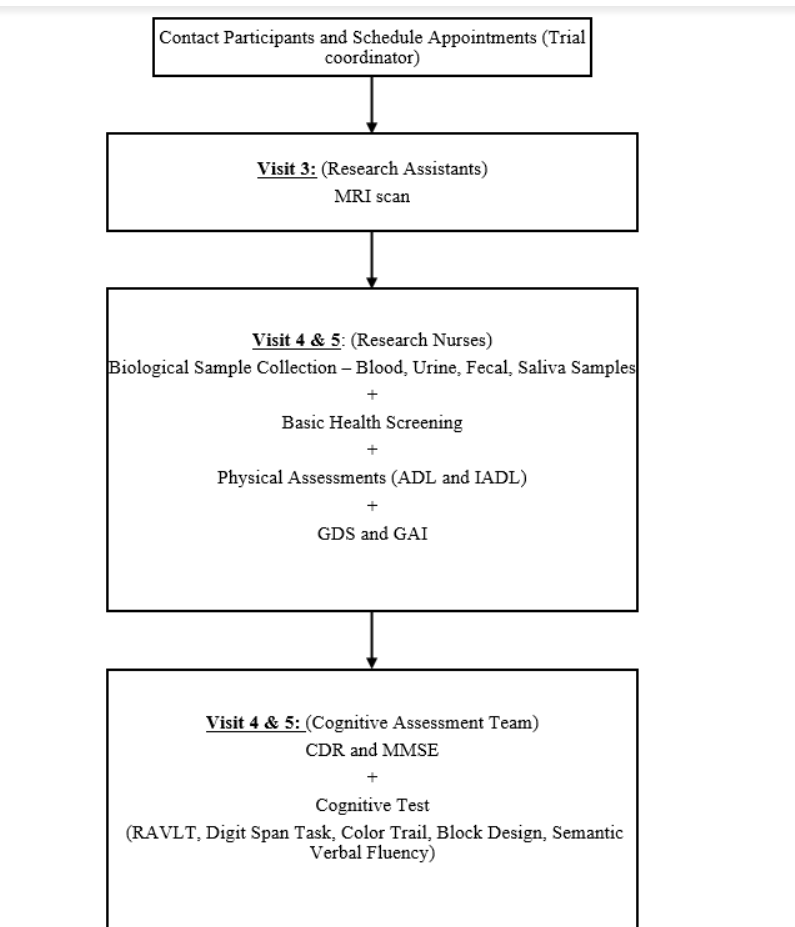
Figure 2. Flow Chart of the Follow-up Assessments at both 3-month and 9-month. MRI = Magnetic Resonance Imaging; ADL = Activities of Daily Living; IADL = Instrumental Activities of Daily Living; GDS = Geriatric Depression Scale; GAI = Geriatric Anxiety Inventory; CDR = Clinical Dementia Rating; RAVLT = Rey Auditory Verbal Learning Test; MMSE = Mini-Mental State Examination.